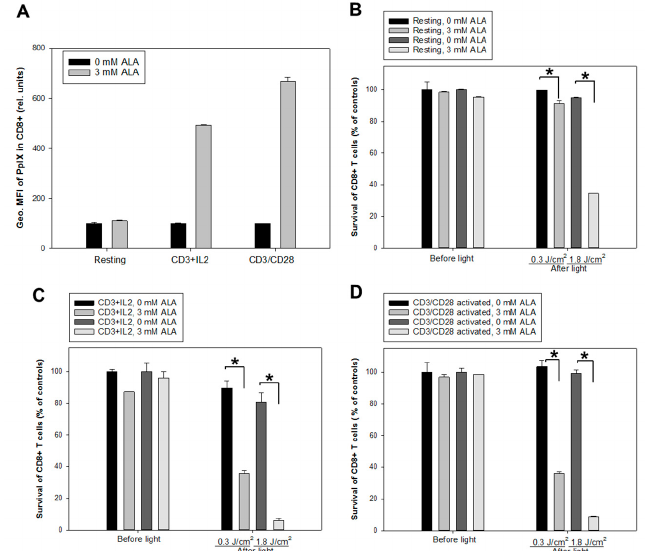
activated cells with anti-CD3 / IL-2 and anti-CD3 / CD28, respectively. * p < 0.05.